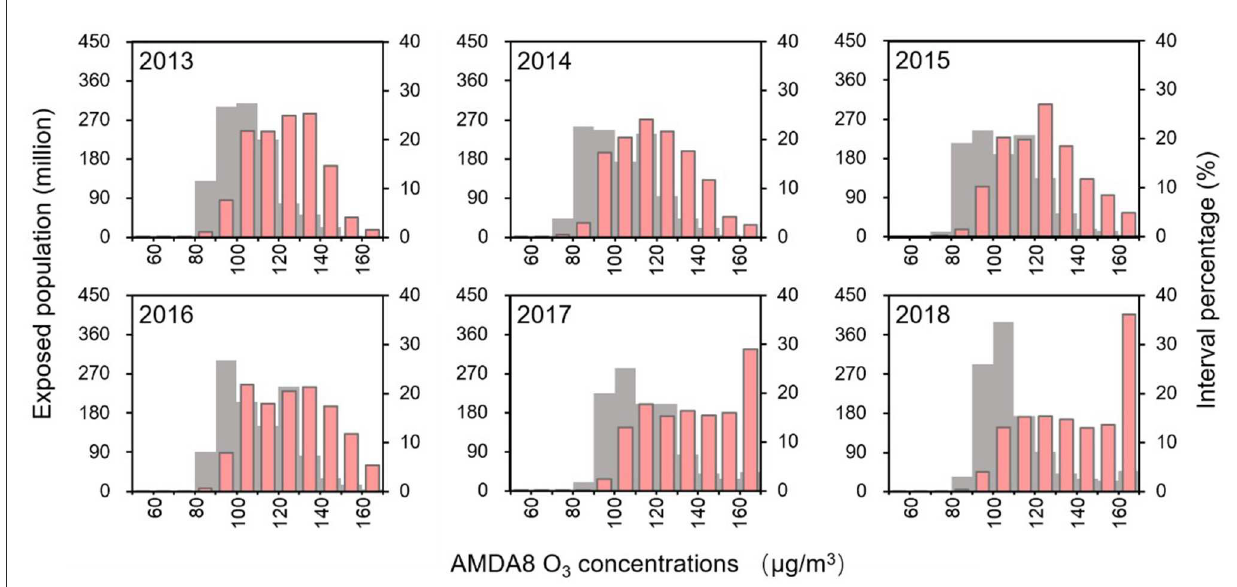
FIGURE5 Probability distribution of the total population exposed to different O 3 concentrations from 2013 to 2018. The red and gray bars indicate the total population and the proportion of the population exposed to different O 3 concentrations, respectively.